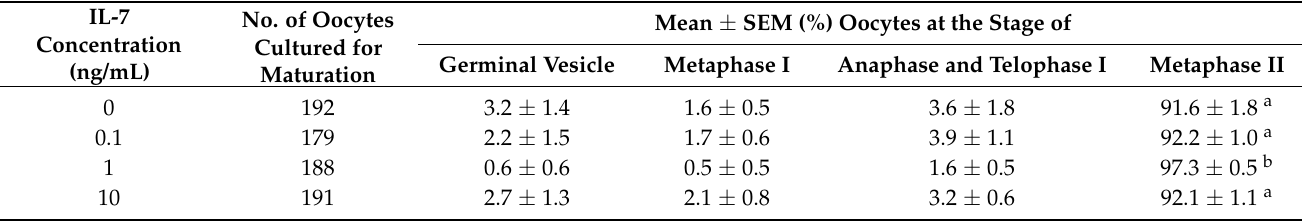
Table 2. Effect of interleukin-7 (IL-7) supplementation during in vitro maturation on nuclear maturation.